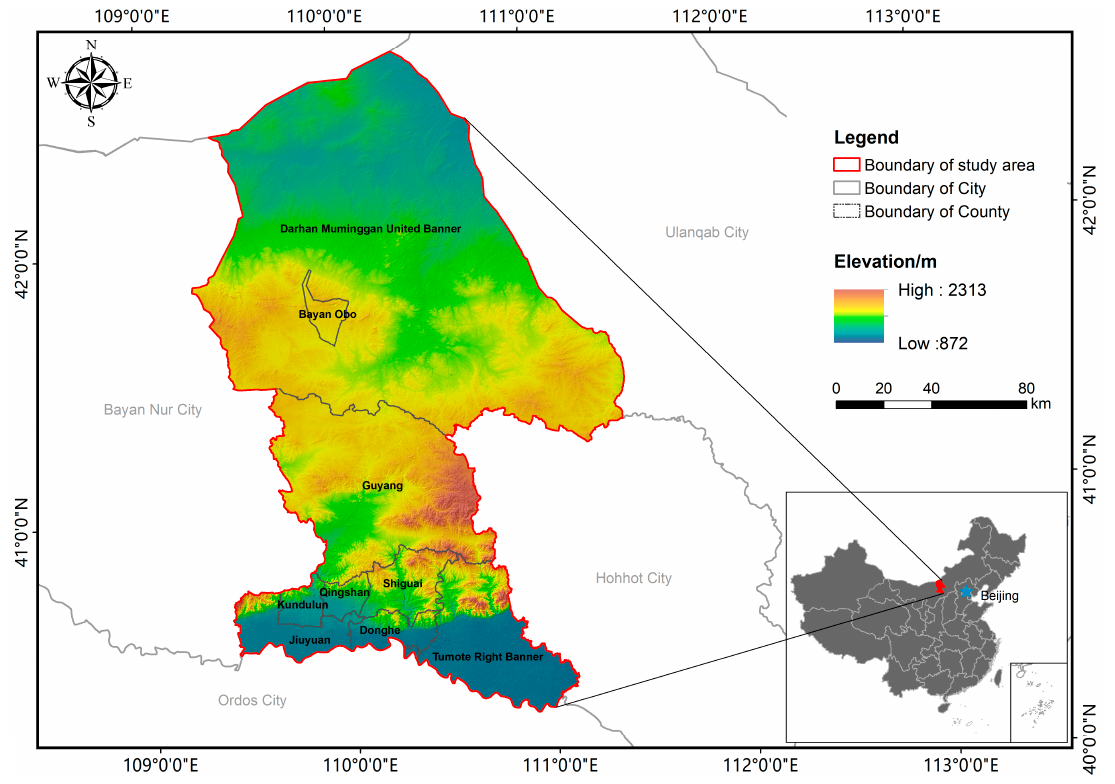
Figure 1. Location of the study area.